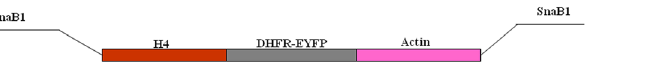
Figure 5. Schematic representation of YFP expressing plasmid: Expression cassette is shown as colored